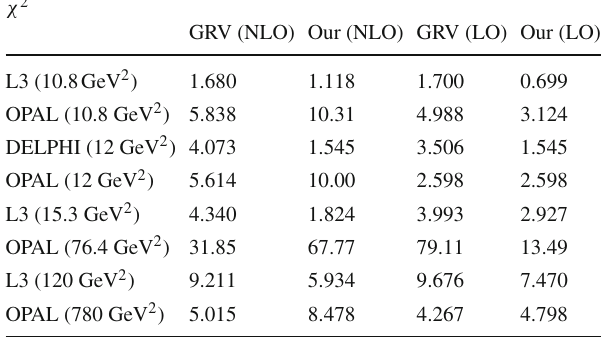
Table 2 χ 2 -values for Our results and the GRV results χ 2